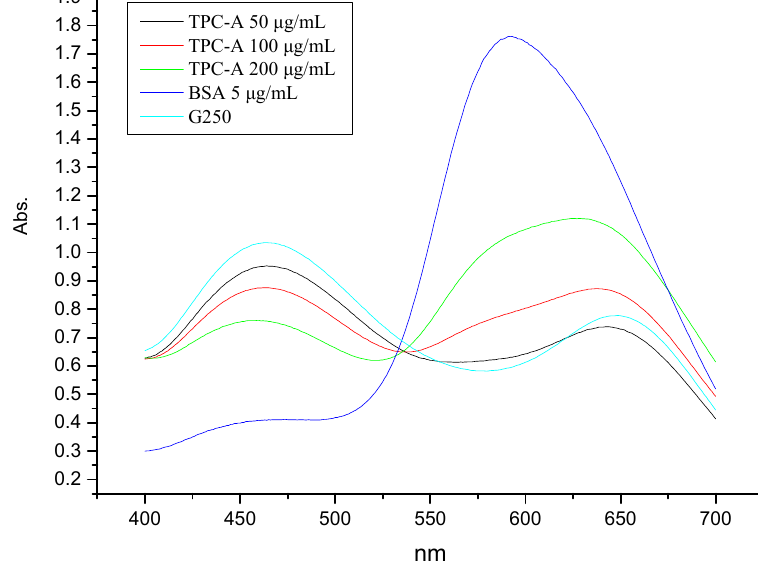
Figure 1. UV-vis absorption spectra of alkali-extracted tea polysaccharide conjugates (TPC-A) and bovine serum albumin (BSA) in Coomassie Brilliant Blue G250 solution.